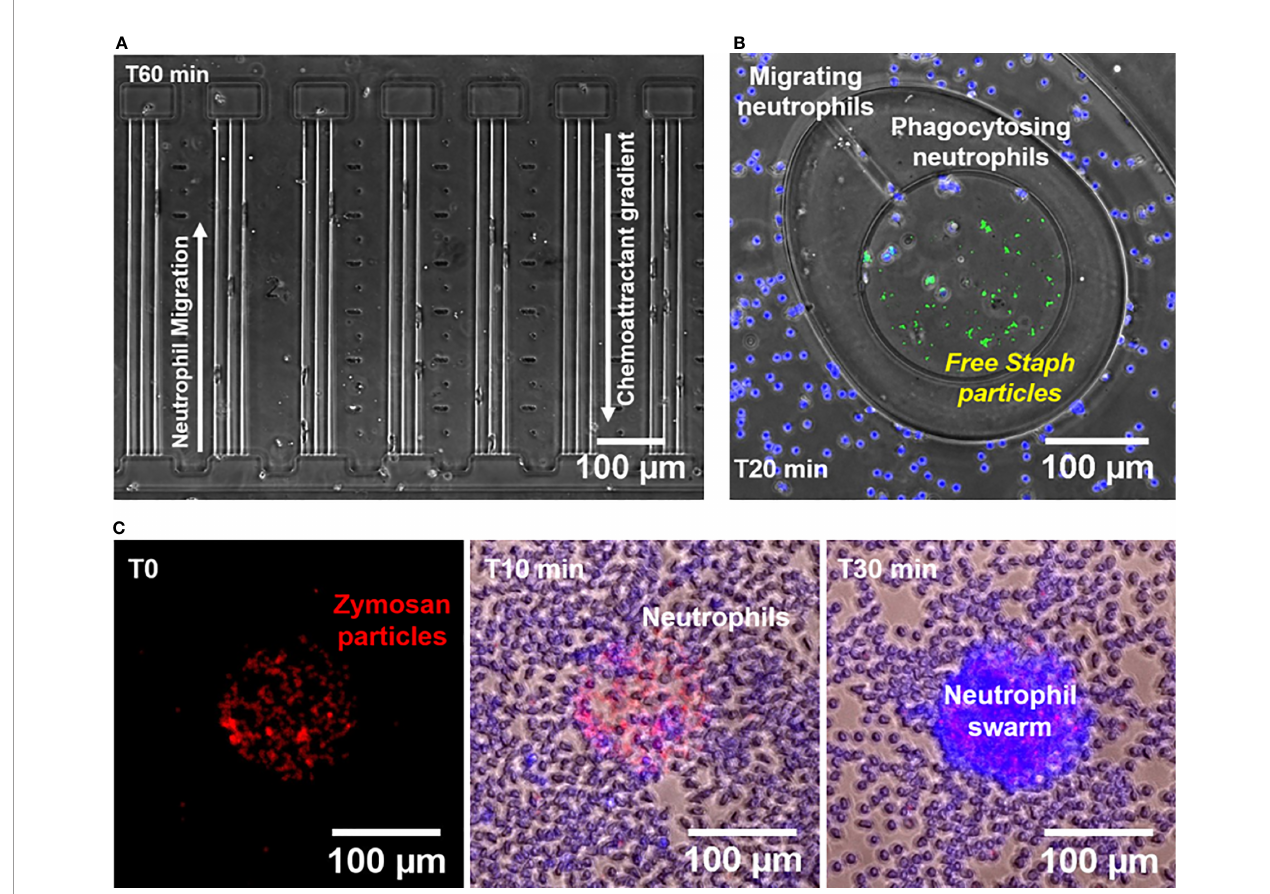
FIGURE 1 | Micro fl uidic devices for measuring neutrophil chemotaxis, phagocytosis, and swarming behaviors. (A) Microscopic image of a segment of the chemotaxis micro fl uidic device (x10 Bright fi eld, Nikon TiE) showing neutrophil chemotaxis towards C5a and C3a during increasing mechanical restriction. Each chemoattractant chamber is connected to the cell loading channel through 3 tapered channels. (B) Microscopic image of a segment of the phagocytosis micro fl uidic device (x10 Bright fi eld/Fluorescent, Nikon TiE) showing neutrophils (blue nuclei) from the outer chamber migrating towards the central reservoir through a migration channel to phagocytose S. aureus particles (green) in plasma at T 20 minutes. (C) Microscopic images obtained at three different time points (T 0 , T 10 , and T 30 minutes) showing the formation of a neutrophil swarm (blue nuclei) over a cluster of Texas red-labeled zymosan A S. cerevisiae bioparticles